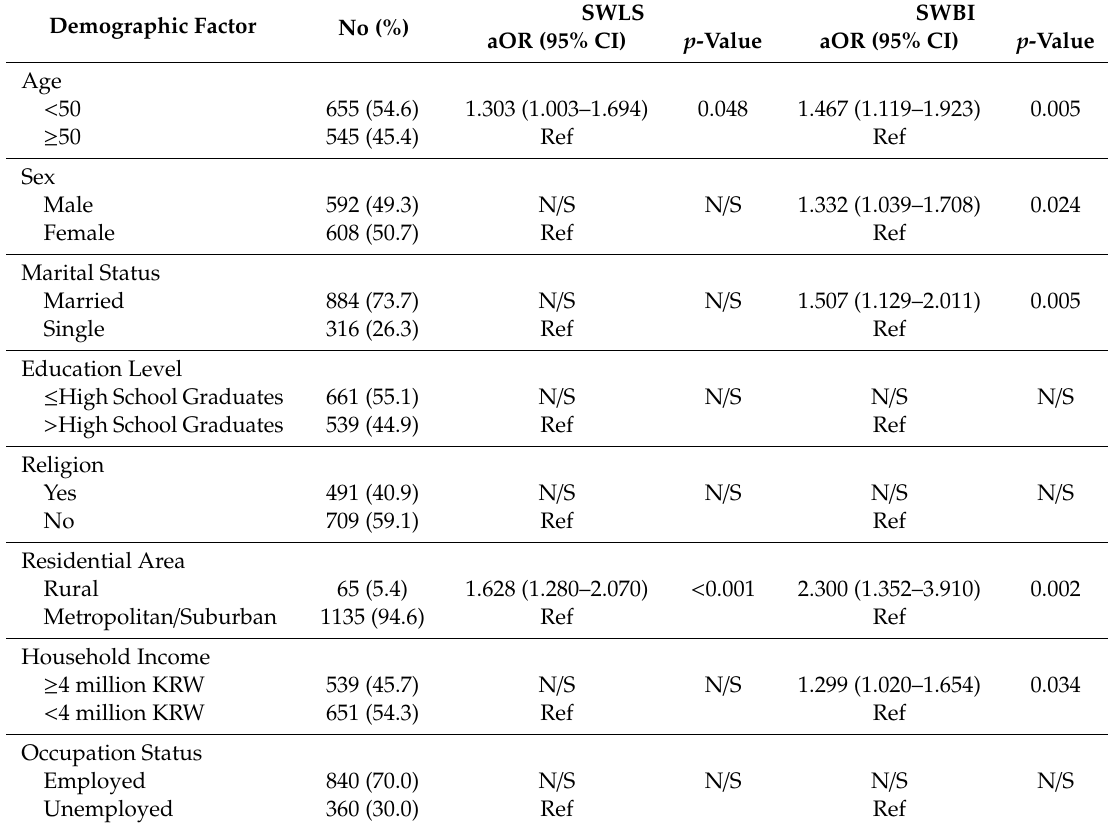
Table 5. Multiple Logistic Regression Analysis of Demographic Factors with SWLS and SWBI